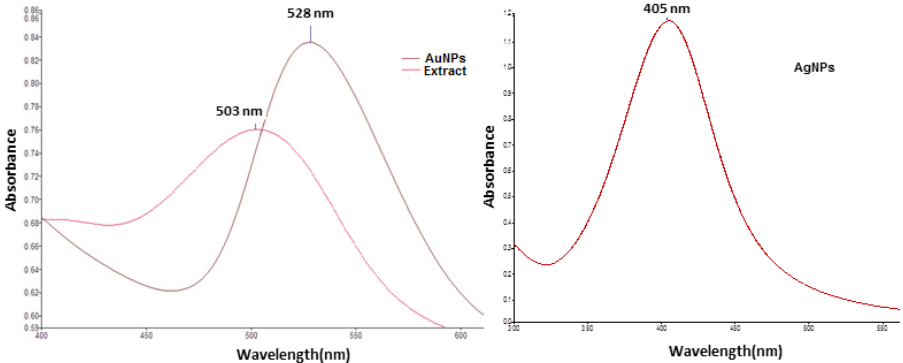
Figure 1. UV–Vis spectra of fruit extract, silver and gold nanoparticles biosynthesized with Cornus mas fruit extract as source of reducing and capping